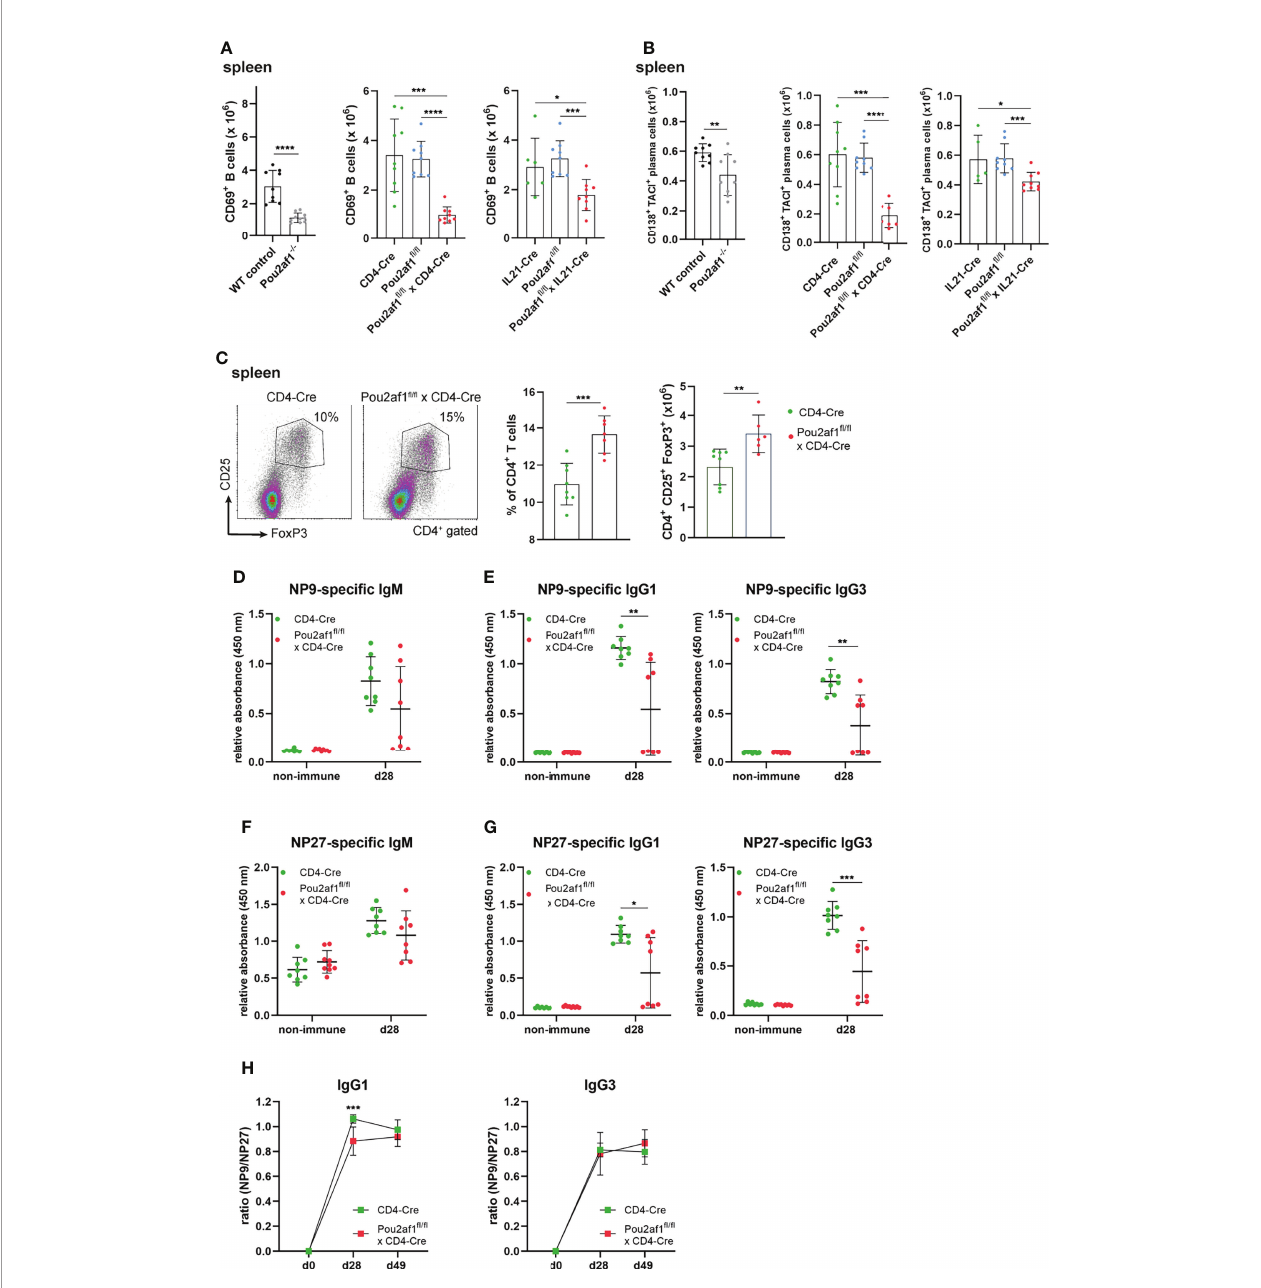
FIGURE 5 | Ablation of BOB.1/OBF.1 in CD4 + T cells results in increased Treg cell levels and reduced antigen-speci fi c immune response. (A, B) Statistics showing numbers of activated CD69 + B (A) and plasma (B) cells in the spleen after immunization. Gating strategy is shown in Figures S11 and S12 (C) . Representative fl ow cytometry plots and statistical analysis of Treg percentage and number in the spleen. Gating strategy is shown in Figure S13 (D – H) ELISA of NP9-speci fi c IgM (D) , NP9-speci fi c IgG1 and IgG3 (E) , NP27-speci fi c IgM (F) and NP27-speci fi c IgG1 and IgG3 (G) in sera of mice before and after 28 days of NP-KLH immunization. Af fi nity maturation calculated by the ratio NP9/NP27 from day 0 to day 49 after immunization is shown (H) . Each point represents data from a single mouse. Data in the graphs are shown as means ± SD (n= at least 6 mice per group). Data are representative for two independent experiments. *p < 0.05, **p < 0.01, *** p< 0.001, and ****p < 0.0001. P-values were determined using a two-tailed Student ’ s t test or Mann-Whitney-U